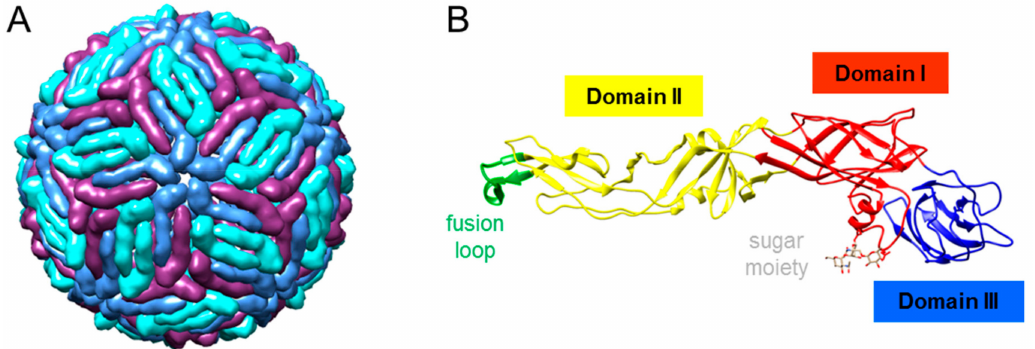
Figure 3. Structure of WNV. ( A ) Cryo-electron microscopy reconstruction of a WNV particle (Protein Data Bank accession 3J0B). E monomers are blue, purple, and turquoise. ( B ) Ribbon diagram of the crystal structure of WNV E glycoprotein (Protein Data Bank accession 2HG0). Domain I is red, domain II is yellow, domain III is blue, and the fusion loop is green. The N-linked sugar moiety of Asn 154 is also displayed. Images were produced using Chimera package